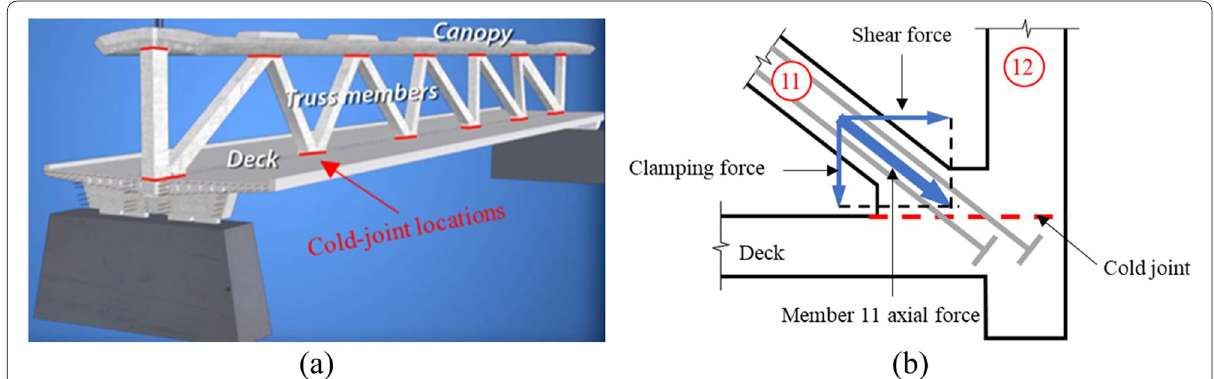
Fig. 7 Cold joints at each end of the truss members caused by concrete casting: a positions of cold joints [12]; and b internal force analysis at the 11–12 nodal